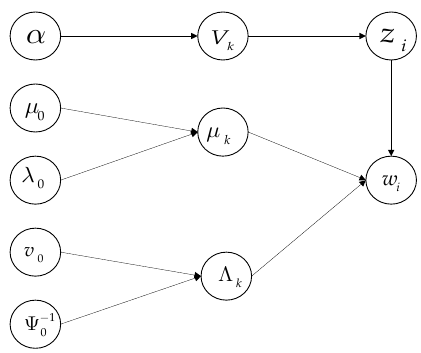
Figure 1. The Dirichlet process Gaussian mixture model.